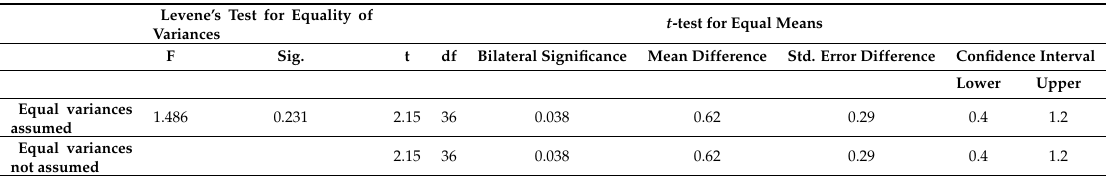
Table 14. Student’s t -test result for Balanced vs Unbalanced